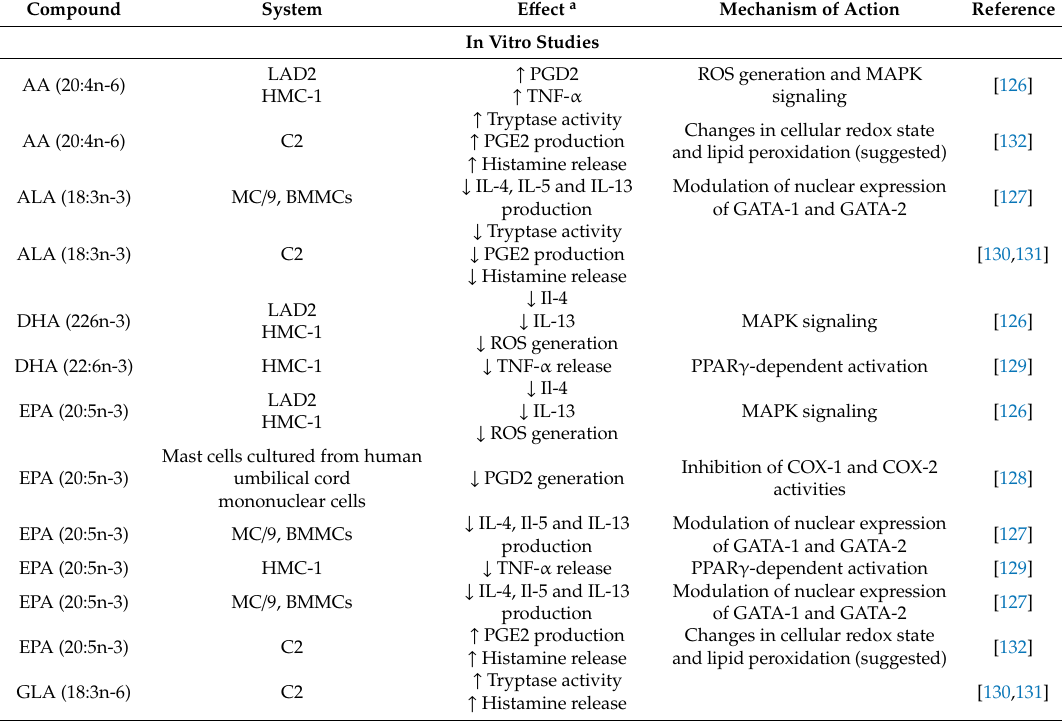
Table 2. Immunomodulatory e ff ects of fatty acids on mast cell